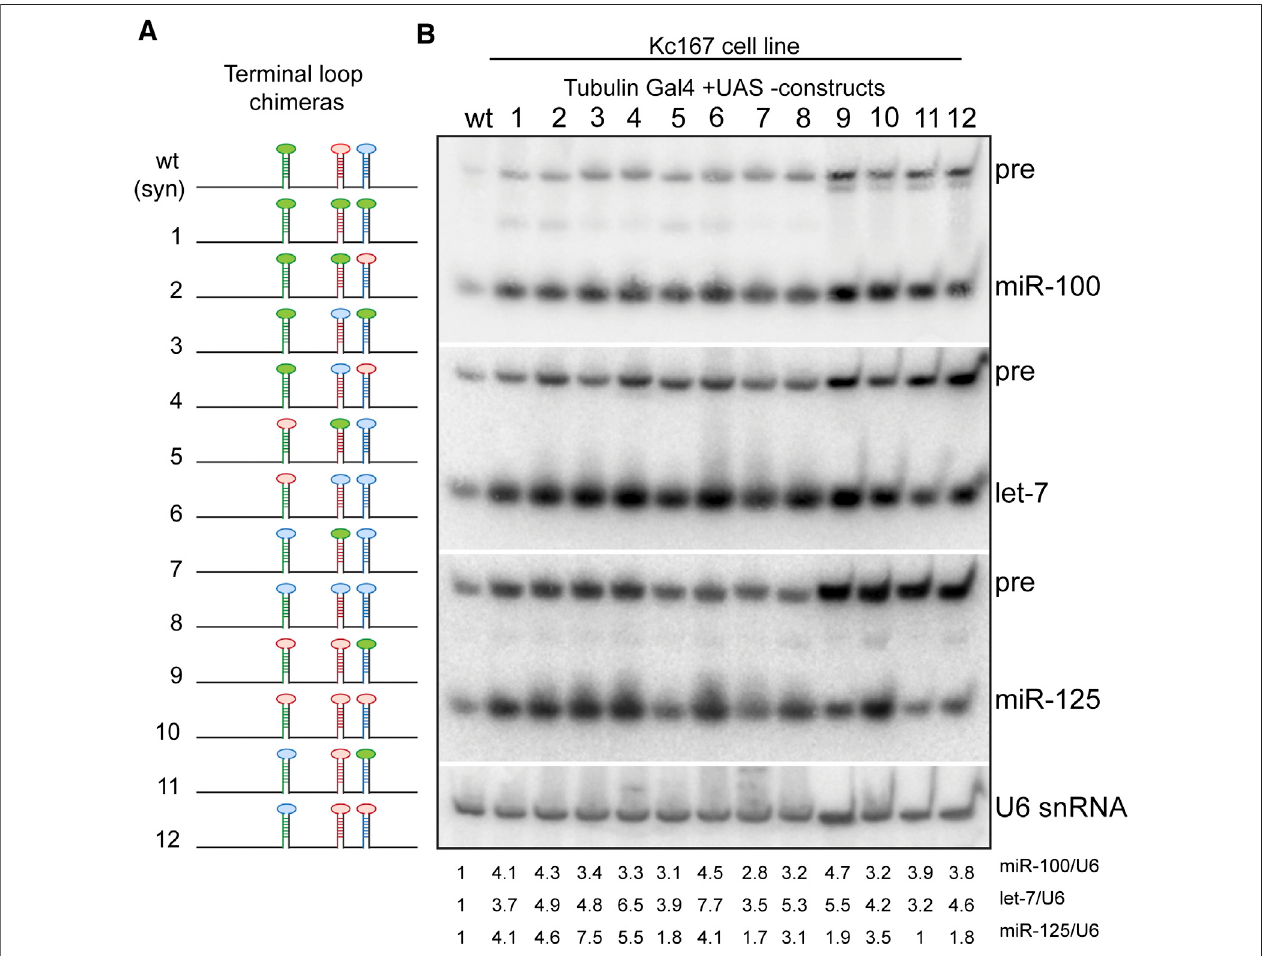
FIGURE 7 | Expression of terminal loop chimeras of primary let-7-C transcript in Kc167 cell line. (A) Schematic of the UAS let-7-C constructs for determining the effectofterminalloopinprocessingof let-7-C miRNAs. (B) NorthernblotanalysisoftransfectedKc167cellsprobedfor miR-100 (toppanel),let-7(middlepanel)andmiR- 125 (bottom panel). Expression plasmids (UAS constructs) were co-transfected with Tubulin Gal4 plasmid and total RNA was extracted after 72 h of transfection. U6 snRNA was used as a control for normalization (lowermost panel) and the normalized levels of processed miRNAs are indicated below the gel.